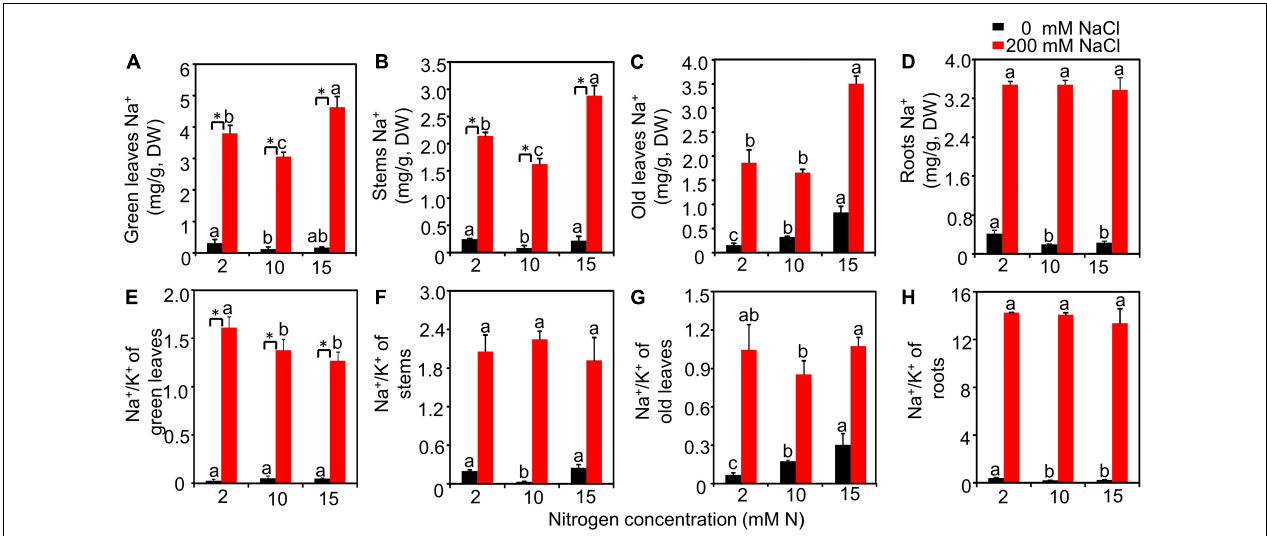
FIGURE 2 | The Na + content and Na + /K + of the bermudagrass under different treatments. Na + content of green leaves (A) , stems (B) , old leaves (C) , and roots (D) and Na + /K + of green leaves (E) , stems (F) , old leaves (G) , and roots (H) of plants grown with different nitrogen concentrations exposed to different NaCl levels, respectively. Different letters above the columns indicate statistically significant differences at P < 0.05 under different N levels with the same NaCl level by Tukey’s test. ∗ Shows significant differences ( P < 0.05) under 200 mM NaCl treatment and 0 mM NaCl condition with the same N level by Tukey’s test.